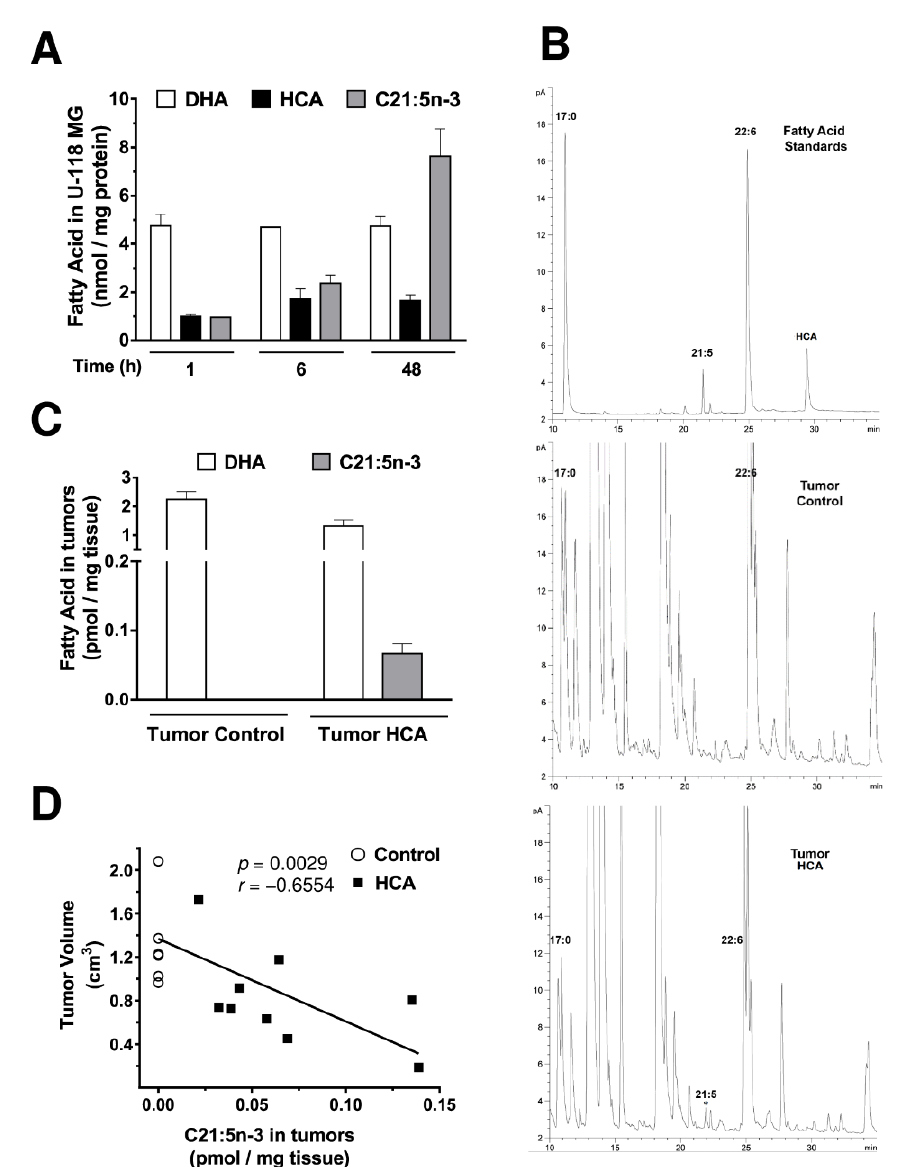
Figure 5. Effect of HCA on the fatty acid composition of U-118 MG cells. ( A ) U-118 MG cells were maintained in the presence or absence of HCA (150 µM) for 1, 6, or 48 h, and the lipids were then extracted from the cells. Fatty acid levels (DHA, HCA, and C21:5n-3) were quantified by GC and identified with standards (bars correspond to the mean ± SEM values of at least 3 independent experiments). ( B , C ) Fatty acid levels (DHA, HCA, and C21:5n-3) were identified by comparison with standards (Standards in the upper panel, Tumor Control in the second panel, and HCA-Treated Tumor in the third panel) and quantified by GC in xenograft tumors (bars correspond to the mean ± SEM values of 7–9 tumors). ( D ) Correlation between the amount of the C21:5n-3 metabolite in tumors and the volume of the tumors. HCA: 2-hydroxycervonic acid; DHA: docosahexaenoic acid; C21:5n-3: heneicosapentaenoic acid; p = p -value; r = Pearson’s correlation